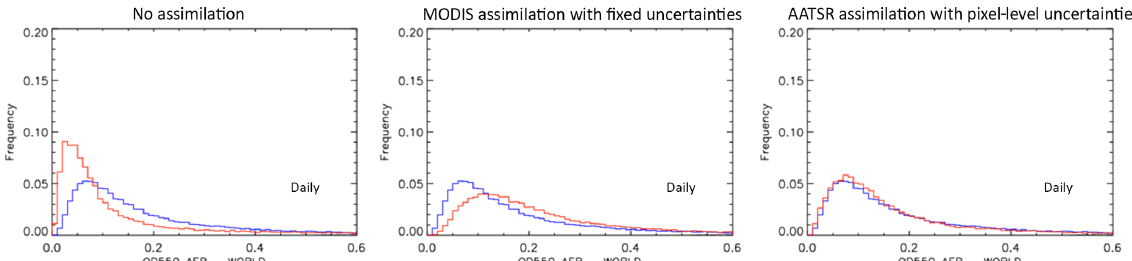
Figure 1. The benefit of pixel-level uncertainties in assimilating aerosol optical depth (AOD) estimated at 550nm into the Monitoring Atmospheric Composition and Climate (MACC) model. Each panel shows a distribution of AOD in the MACC model (in red) matched to 29528 AERONET ground-based AOD values (in blue): (left) no data assimilation; (centre) assimilation of MODIS retrievals; (right) assimilation of AATSR retrievals. The AERONET-measured values have negligible uncertainty compared to satellite data. The MODIS data were the dark target AOD dataset (collection 5.1), which was operational in MACC using fixed (generic) uncertainty estimates of 0.1 over land and 0.05 over ocean. These values were chosen after bias correction and thorough testing of alternative uncertainty assumptions (Benedetti et al., 2008). The AATSR dataset was from Aerosol CCI, and its pixel-level uncertainty estimates were used (with no bias correction). The improved agreement in aerosol distribution suggests that the use of pixel-level uncertainties is